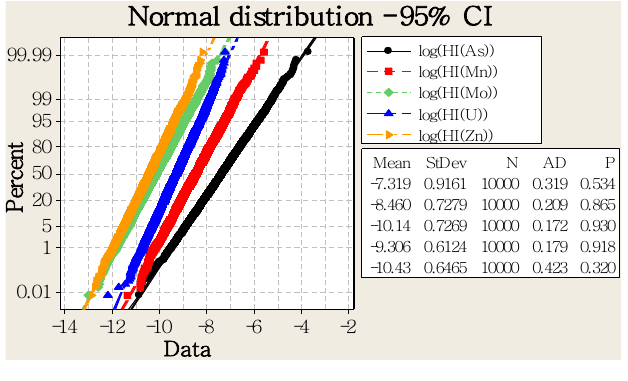
Figure 5. Probability plot of log(hazard index (HI)) for five heavy metals and the corresponding